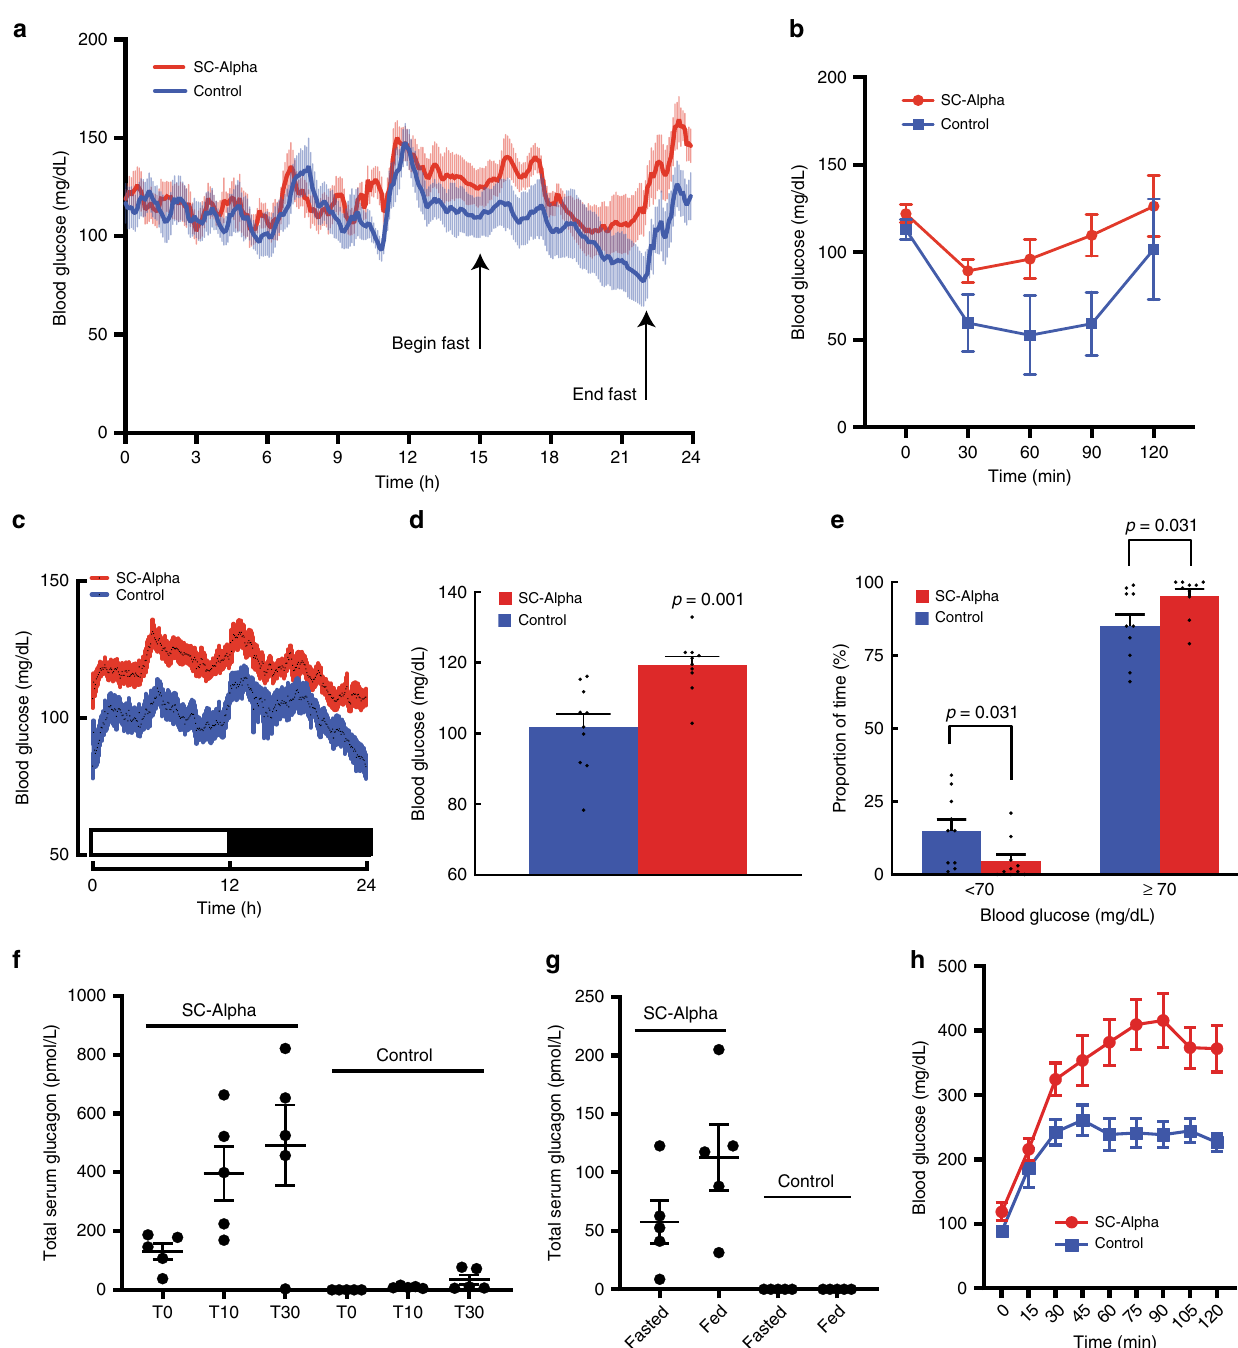
Fig. 6 In vivo characterization of SC-alpha cell transplantation. a Fasting-induced hypoglycemia in control ( n = 9 animals) and SC-alpha transplanted mice ( n = 9 animals). Continuous glucose monitoring for 24-h period at 5 weeks post transplant. Food was removed after 15 h and restored at 22 h. SC-alpha-cell-transplanted mice are protected from hypoglycemia. b Insulin tolerance test on control ( n = 9 animals) and SC-alpha ( n = 9 animals) transplanted mice at 6 weeks post transplant. SC-alpha-cell-transplanted mice are protected from hypoglycema. c Continuous glucose monitoring of mice for 4 weeks reveals that mice transplanted with SC-alpha cells ( n = 10 animals) have elevated blood glucose compared to control animals (sham surgery, n = 10 animals). Graph represents the average daily blood glucose value at 5-min intervals for all animals in each treatment group. Each data point represents the average of 280 CGM readings (10 mice × 28 days). d In transplanted mice, SC-alpha cells reduce instances of hypoglycemia in mice. Average blood glucose reading by CGM over 28-day period ( n = 10 animals for each group). e Percentage of time over 4 weeks spent in range ( ≥ 70 mg/dL) and hypoglycemic (<70 mg/dL) ( n = 10 animals for each group). f Total serum glucagon levels in response to an arginine bolus at 4 weeks post transplant. SC-alpha-transplanted mice ( n = 5 animals) and control animals ( n = 5 animals) were fed ad libitum and injected i.p. with arginine. Total serum glucagon levels were measured at time 0 (T0), 10 and 30 min post injection. g Fasting and fed total serum glucagon levels for control ( n = 5 animals) and SC-alpha ( n = 5 animals) transplanted animals. Fasted mice were deprived of food for 6 h before blood collection. Blood was collected from fed animals 2 h after food was restored. h Glucose tolerance test in control mice ( n = 5 animals) and SC-alpha-transplanted mice ( n = 5 animals). All data are presented as mean ± SEM. Signi fi cance was calculated using a two-tailed unpaired Student ’ s t